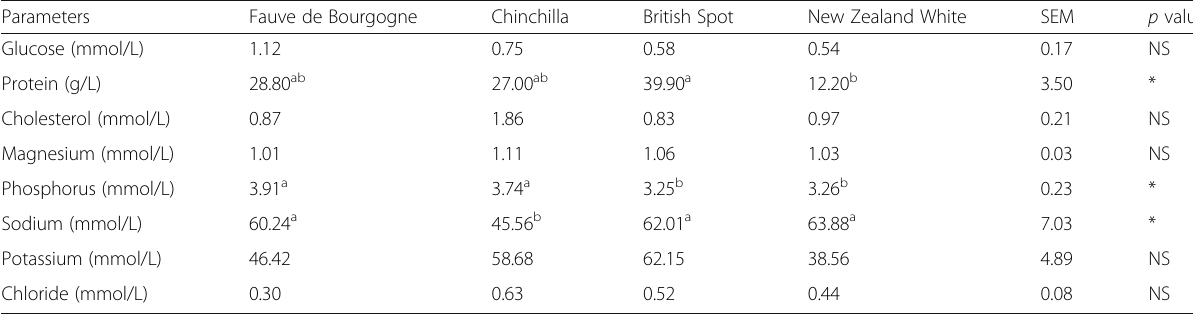
Table 2 Seminal biochemistry of four exotic breeds of rabbit